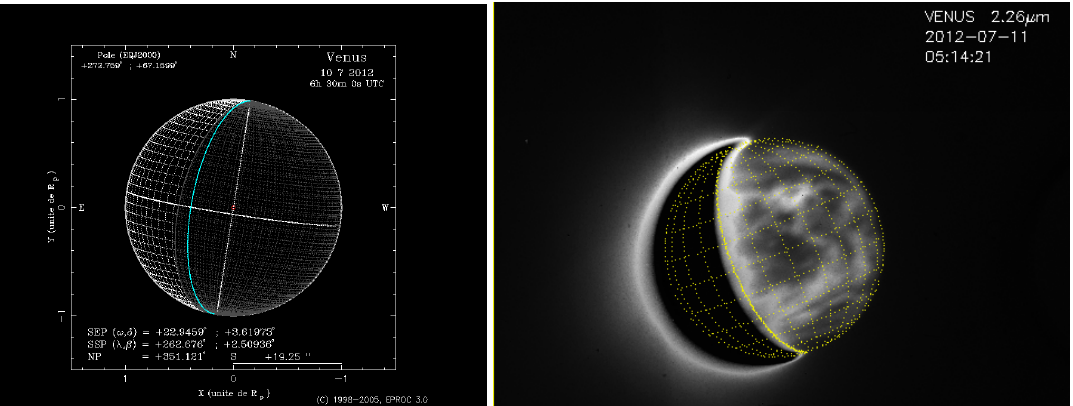
Figure 2. Left : we can see the geometry of the ground-based observations. It also shows the apparent size of Venus on 11th of June 2012, as it was seen at the Telescopio Nazionale Galileo (TNG) site at the La Palma’s observatory. Right : example of observations of the nightside of Venus where our use of SPICE kernels provided accurate positional referencing of the images. In the observations that we performed, we note that by using SPICE kernels for obtaining an accurate positional reference, we were able to very accurately assign to each pixel in the image their latitude and longitude data (besides the presented grid).